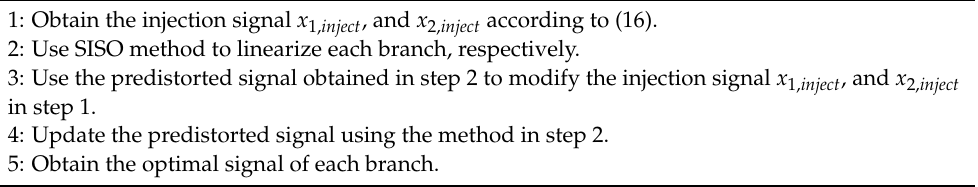
Algorithm 1 Algorithm of Proposed Method